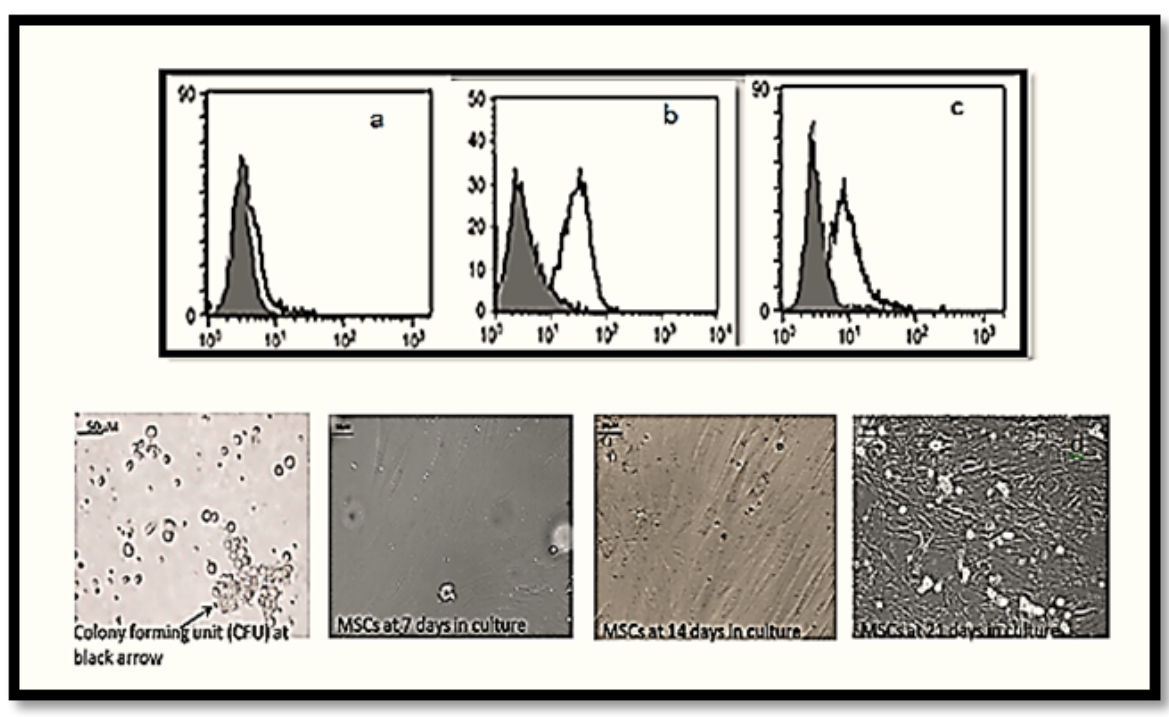
Figure 1: Characterization of HPDLSC immunological characterization (upper section) (a, b, and c) and phenotypical characterization (lower section)